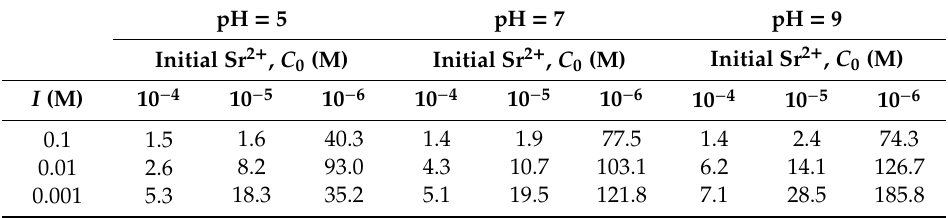
Table 1. Measured retardation factor ( R f ) from saturated breakthrough curves for all combinations of conditions studied. Values were determined by integrating to find the area above the dimensionless breakthrough curves.